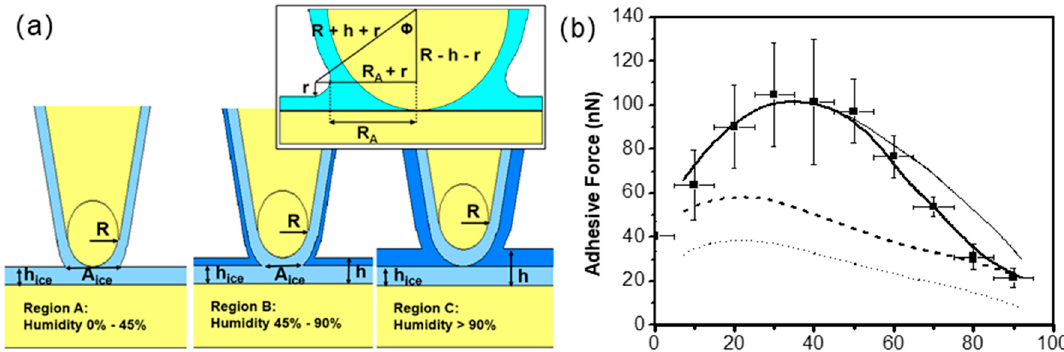
Figure 14. ( a ) Schematics of the silicon tip (covered with a native oxide layer) position on silicon oxide surface and solid-adsorbate-solid contact area as a function of RH. ( b ) Simulation of the contributions from capillary force term F c , van der Waals term F vdW , and the solid-like water bridge term F h . The bottom dotted line represents the maximum F c . The middle-dashed line represents F c + F vdW . The solid lines represent the sum of three components, F h + F c + F vdW . Reprinted from Ref. [81], Copyright 2006, with permission from AIP publications.